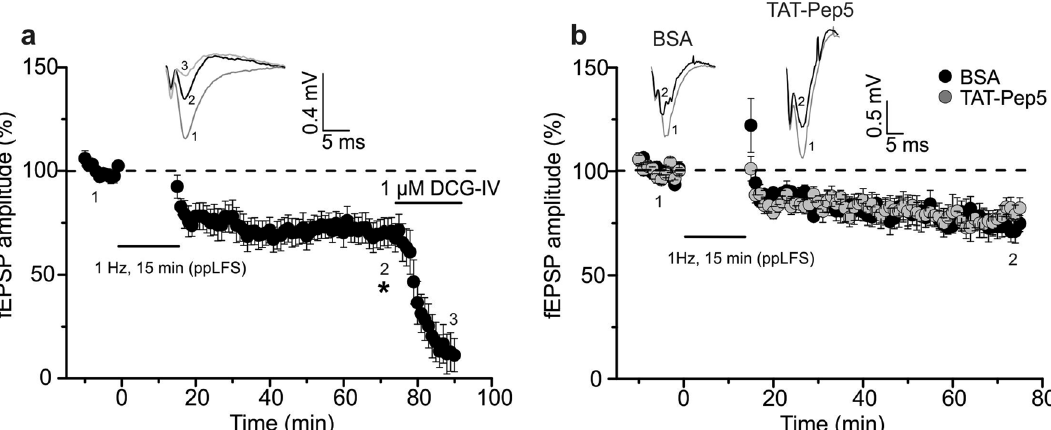
Figure 3. Paired-pulse LFS induced LTD at MF-CA3 synapses is also independent of p75NTR signaling. ( a ) Paired-pulse (pp) LFS induced significant LTD at MF synapses (filled circle: ppLFS (n = 10/N = 7)). The inset shows representative averaged original fEPSP responses. For MF-LTD, “1” depicts mean fEPSP amplitudes of first 10 min of baseline, “2” depict mean fEPSP amplitudes between 55 and 60 min after induction of LTD, and “3” shows mean fEPSP amplitude after DCG-IV incubation to verify pure MF origin. ( b ) MF-CA3 synapses exhibited comparable LTD magnitude in presence of TAT-Pep5 (1 µM; p75NTR inhibitor) compared to BSA control (filled circle: BSA (n = 8/N = 5); filled gray circle: TAT-Pep5 (n = 10/N = 5)). The inset shows representative averaged original fEPSP responses. For MF-LTD in BSA and in the presence of TAT-Pep5, “1” depicts mean fEPSP amplitudes of first 10 min of baseline and “2” depict mean fEPSP amplitudes between 55 and 60 min after induction of LTD. Data shown as mean ± SEM. Corresponding scale bars are shown as insets. *p < 0.05 (1-sample Student’s t-test or two-tailed Student’s